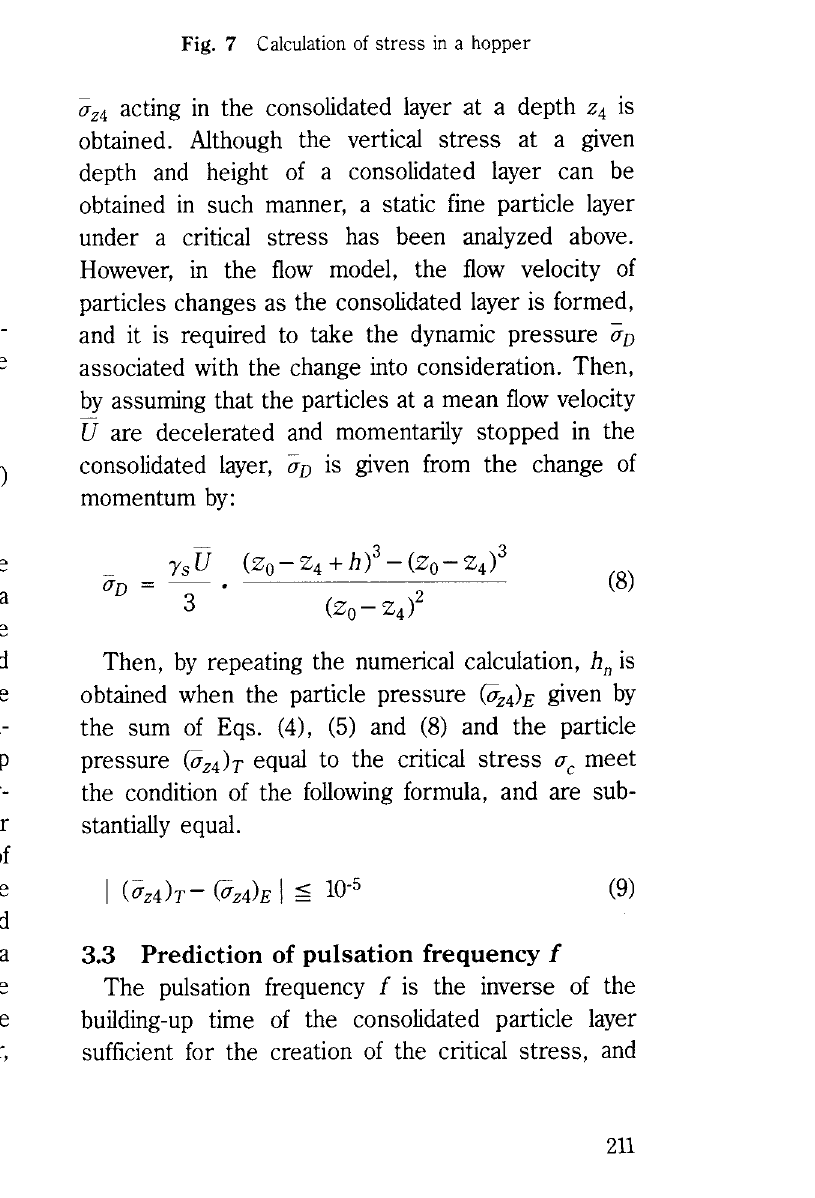
Fig. 7 Calculation of stress in a